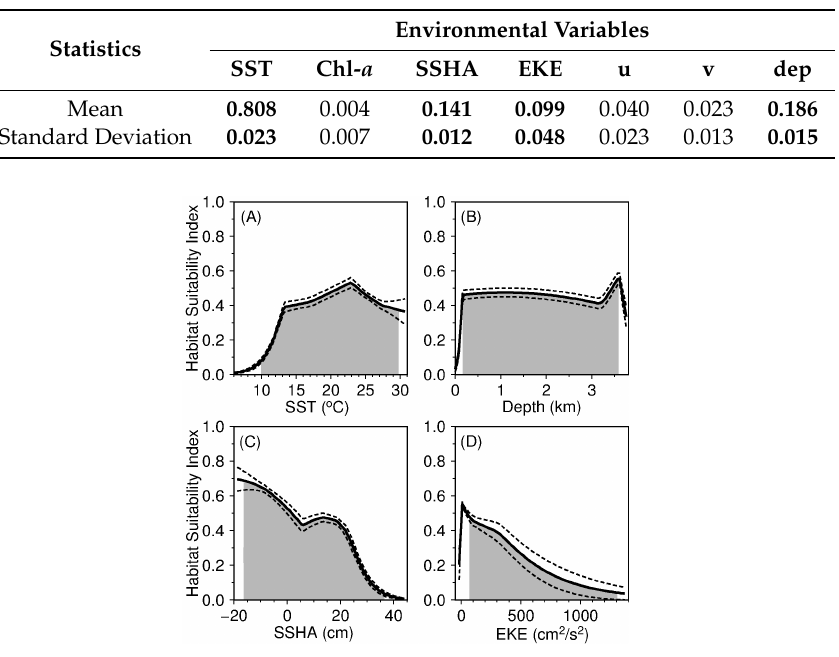
Figure 3. Response curves of the most highly influential environmental factors: ( A ) SST; ( B ) depth; ( C ) SSHA; and ( D ) EKE, averaged from 10 MaxEnt model simulations. Broken lines correspond to ± 1 standard deviation and shaded regions correspond to the area within the 5th and 95th percentiles.